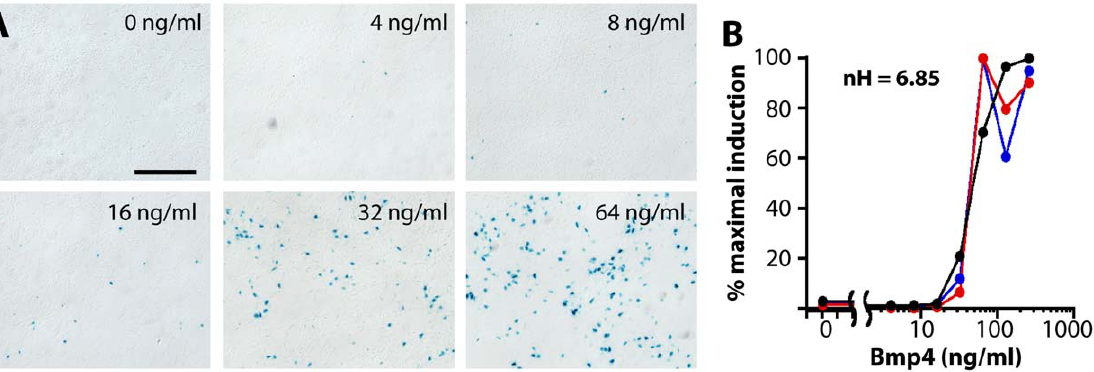
Figure 4. Ultrasensitive BRE-gal induction by Bmp4 invitro . ( A ) Xgal stains, dissociated E12.5 cortical cells. BRE-gal expression displays a threshold effect, with strong activation occurring between 16–32 ng/ml. At all concentrations, BRE-gal induction is highly mosaic. Scale bar: 200 um. ( B ) RT-qPCR, dissociated E12.5 cortical cells. BRE-gal activation is consistent and highly sigmoidal (three independent cultures graphed separately), with an EC50 of 42.23 ng/ml ( + / 2 0.15) and a Hill coefficient of 6.85 ( + / 2